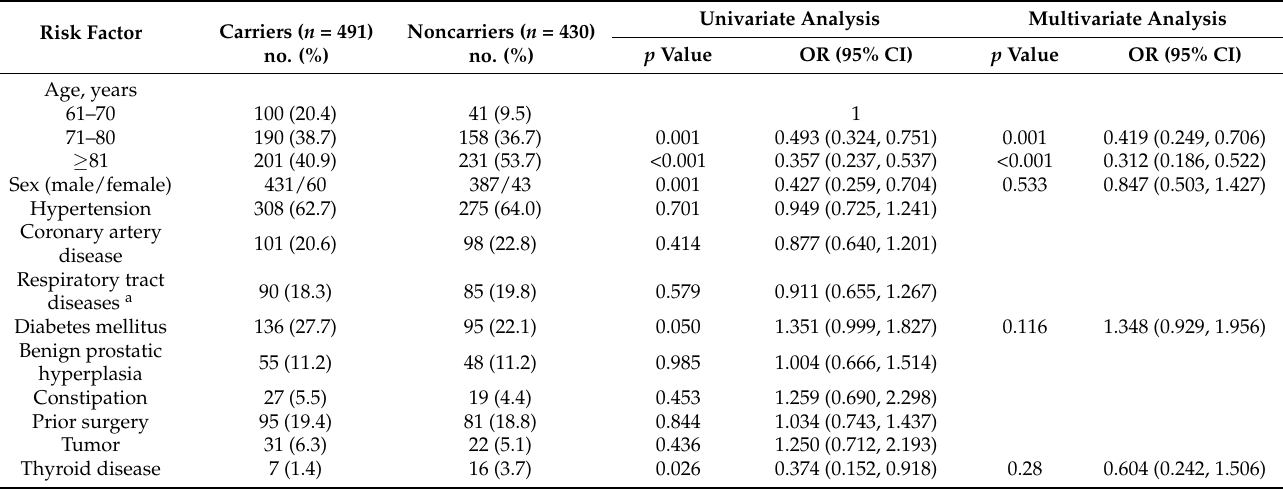
Table 2. Univariate and multivariate analyses of the risk factors for intestinal carriage of ESBL- producing Enterobacteriaceae in the